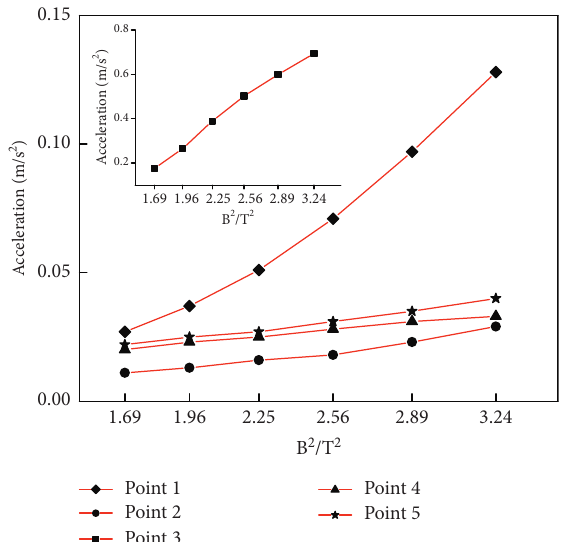
Figure 15: Acceleration values at various measurement points under different magnetic densities.